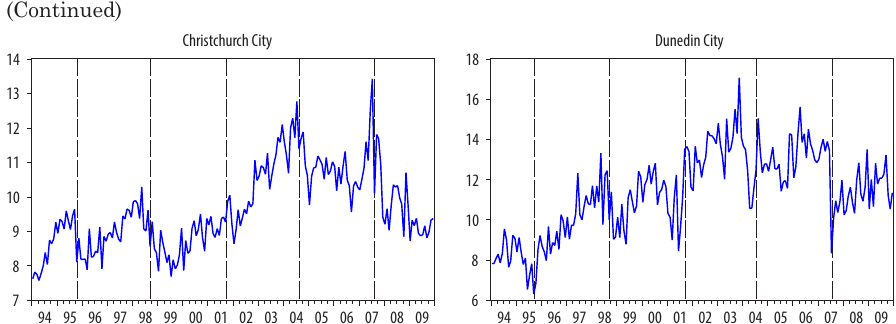
Fig. 1. Estimated monthly coefficient of dispersion (COD) of assessment ratios over time, Jan. 1994 to Dec. 2009 Notes: The vertical line drawn on the date axis indicates the time of reassessment.